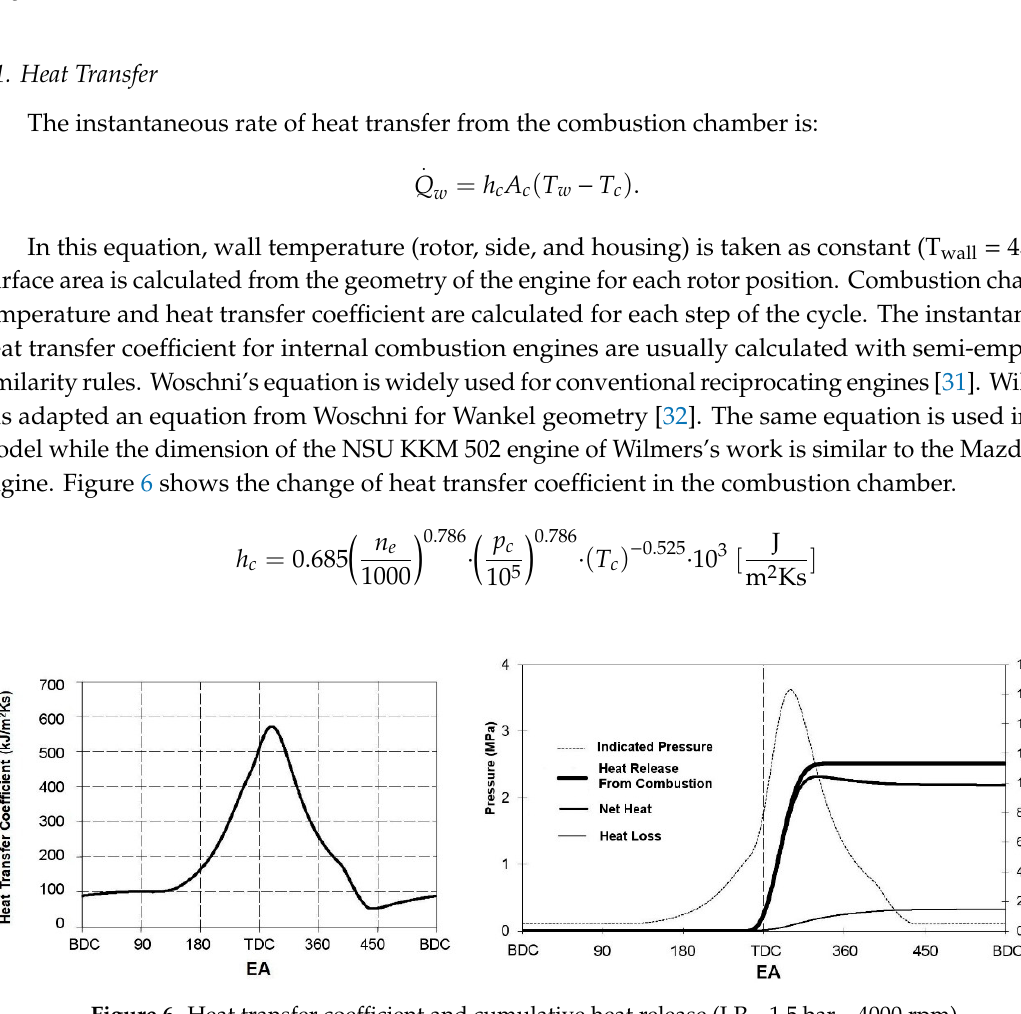
Figure 6. Heat transfer coefficient and cumulative heat release (LP – 1.5 bar – 4000 rpm).